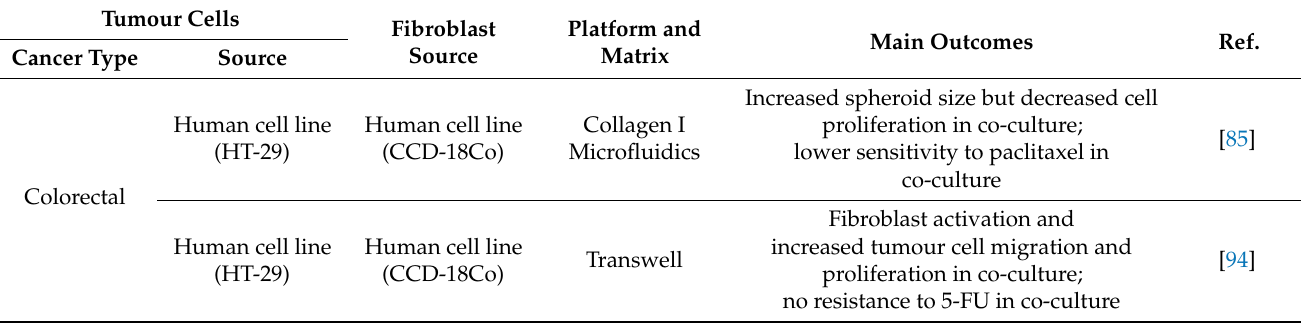
Figure 1. Schematic representation of cancer-associated fibroblasts’ (CAF) phenotype, their interactions and reciprocal effects on tumour cells and other non-malignant cells of the tumour microenvironment, and effects of chemotherapy [11,19,86,88,93]. Image created with BioRender. CAF: Cancer-associated fibroblast; CCL2: C-C motif chemokine ligand 2; CXCL12: C-X-C motif chemokine ligand 12; ECM: Extracellular matrix; HGF: Hepatocyte growth factor; IDO: Indoleamine 2,3-dioxygenase; IL-6: Interleukin 6; IL-10: Interleukin 10; M-CSF: Macrophage-colony stimulating factor; TGF- β : Transforming growth factor β .